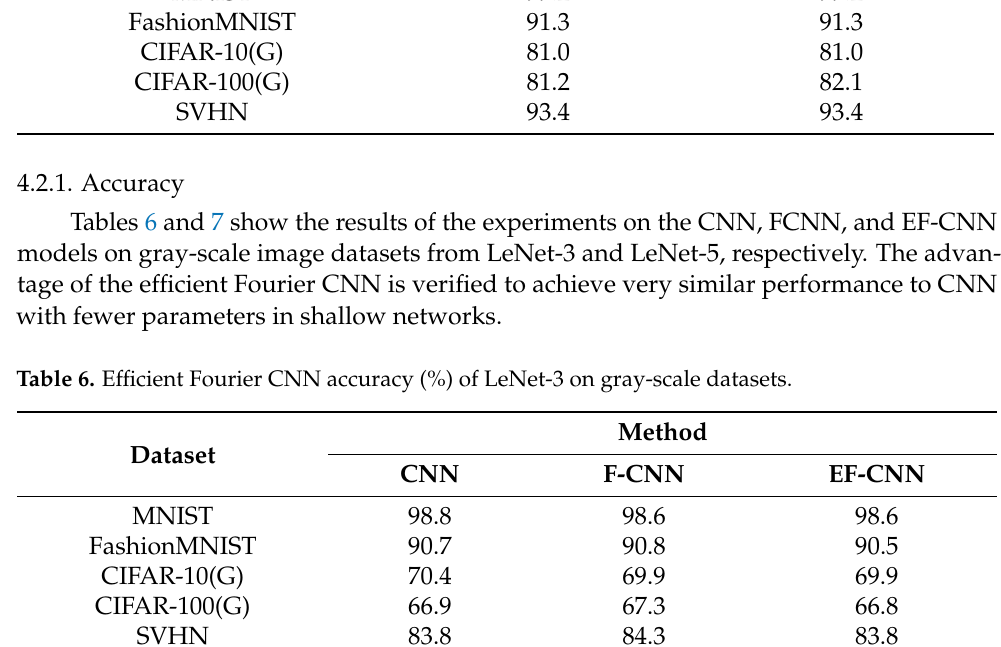
Table 7. Efficient Fourier CNN accuracy (%) of LeNet-5 on gray-scale datasets.